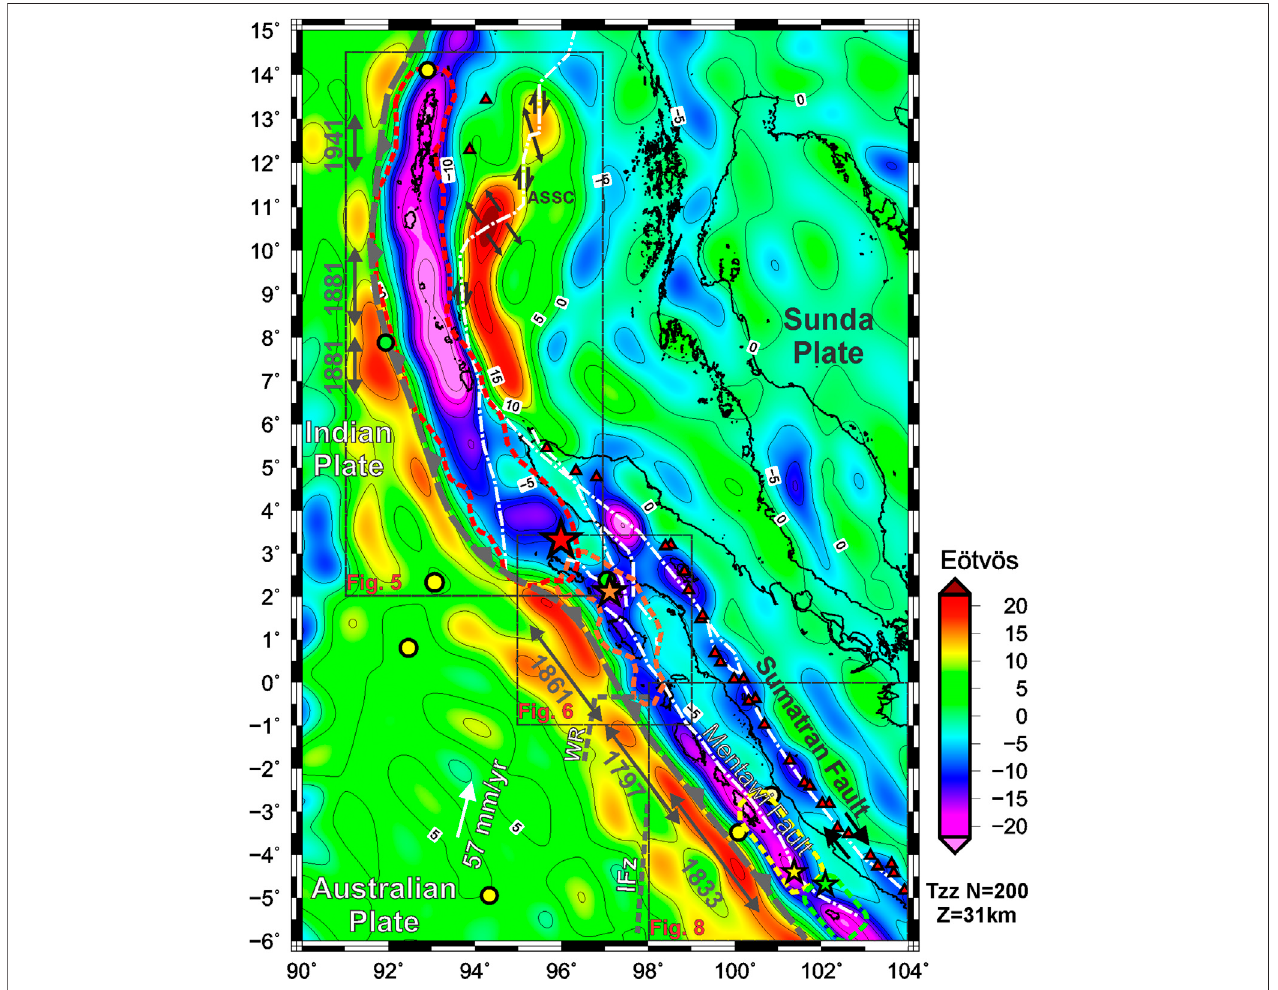
FIGURE 3 | Topography corrected vertical gravity gradient (Tzz) obtained from GOCE model GO_CONS_GCF_2_DIR_R6 up to N (cid:1) 200 (Bruinsma et al., 2014). The forebulge presents a high gravity gradient signal while lower to negative values are observed along the outer forearc, to the Northwest is clearly depicted the Andaman Sea Spreading Center (ASSC). Historical great earthquakes are indicated with gray double-arrows. The dimensions of the approximate rupture areas for four of the last great earthquakes along the Sumatra-Andaman margin are indicated with dashed lines. Stars indicate epicenter location of the Mw (cid:1) 9.15 2004 Sumatra-Andaman earthquake (yellow), the Mw (cid:1) 8.6 2005 Nias – Simeulue earthquake (orange), the Mw (cid:1) 7.9 2007 Kepulauan-Mentawai earthquake (red), and the Mw (cid:1) 7.9 2000 Southern Sumatra earthquake (green). Rectangles indicate the location of Figures 5 , 6 , and 8 . IFz: investigator fracture zone, WR: Wharton ridge.